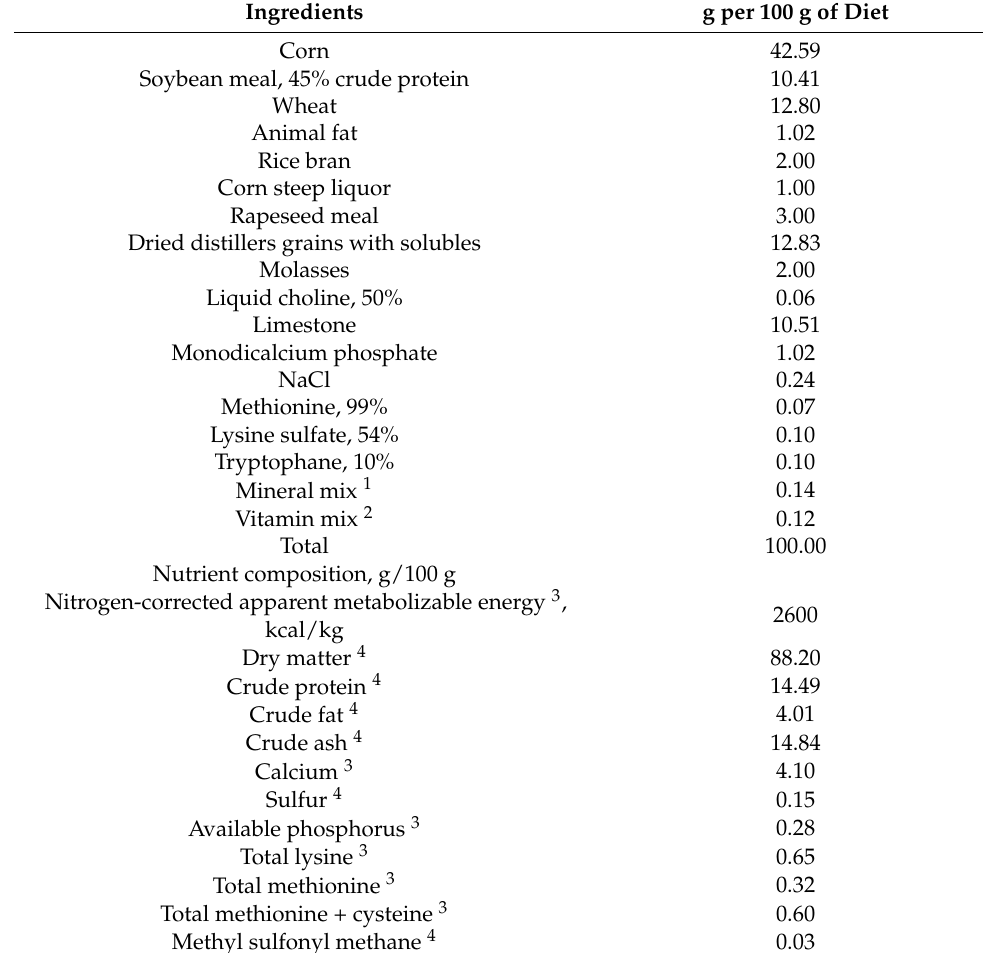
Table 1. Ingredient and nutrient composition of the basal